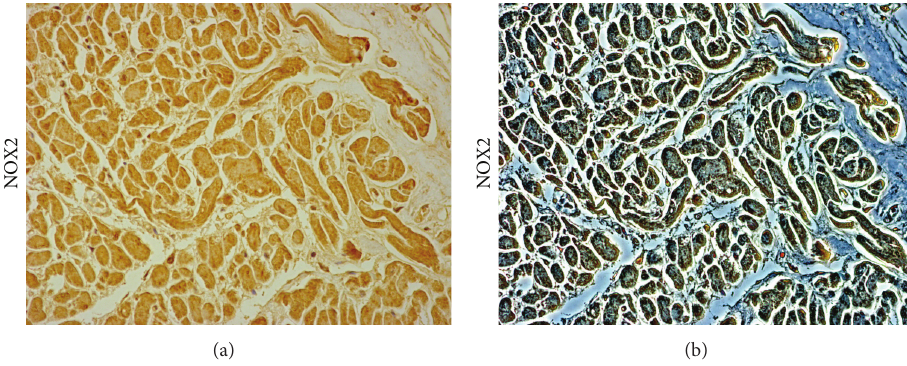
Figure 1: NOX2 expression in the cardiac tissue of a patient died following sepsis. Bright field (a) and contrast phase (b) microscopy image of human cardiac sample, demonstrating a moderate immunopositivity to anti-NOX 2 antibody (Santa Cruz, CA, USA). Personal observation of a 45-year-old septic patient admitted to an emergency unit due to acute abdominal pain and constipation. Abdominal X-ray revealed large amount of fecal content in the colon and dilated small bowel suggestive of bowel obstruction from fecal impaction. The patient was started on broad spectrum antibiotics after pan cultures were obtained and intravenous fluids were administered, and surgical evaluation was requested for possible surgical intervention of bowel obstruction. However, he had a rapid decline in clinical status with worsening hypotension. An echocardiogram revealed severe left ventricular dysfunction (EF 37%) and dilatation of the right ventricle with medium-apical akinesis. Despite a vigorous fluid resuscitation, dopamine, dobutamine, and norepinephrine infusion, the patient